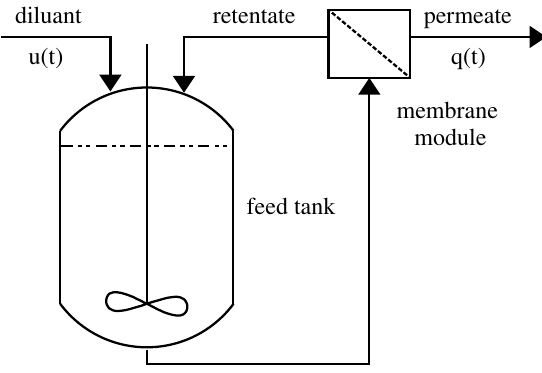
Figure 1. Schematic representation of a generalized ultrafiltration/diafiltration